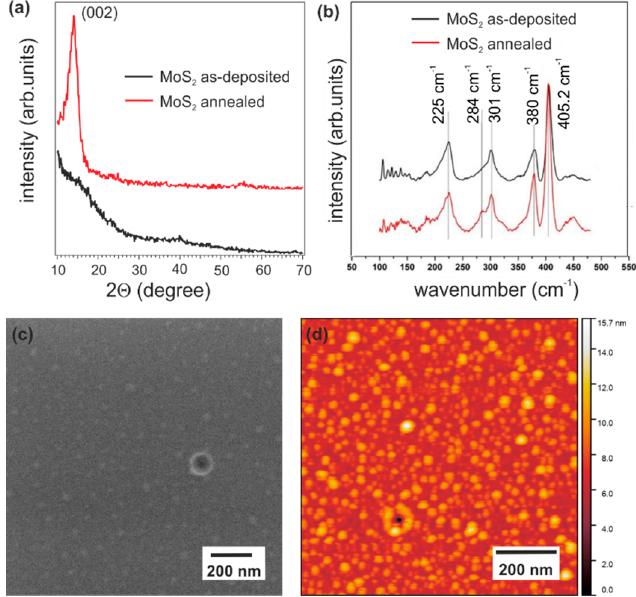
Figure 4. ( a ) XRD spectrum of IJD-MoS 2 deposited at 18 kV and annealed at 380 °C; ( b ) μ -Raman